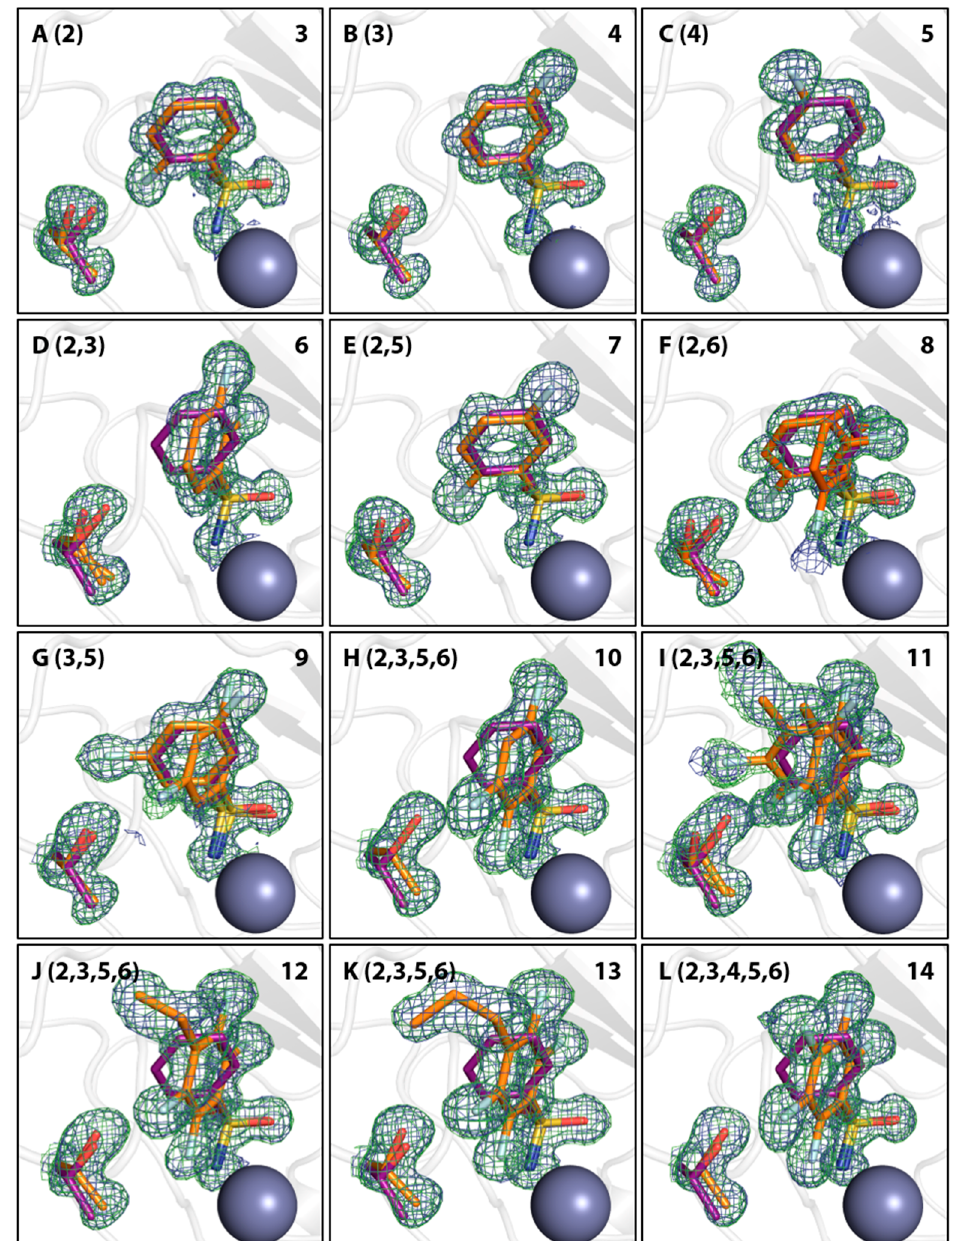
Figure 2. Binding modes of fluorinated compounds and side chains of the respective Thr200 residue in orange in images ( A – L ). Fluorinated positions at the phenyl ring relative to the sulfonamide bearing carbon atom (position 1) are given in parentheses. Compound numbers according to Table 1 are given in the upper right corner. Compound 1 is shown in all images for comparison in purple. Omit 2mFo-DFc density is shown in blue at 1 σ and omit mFo-DFc density in green at 3 σ . The Zn II cofactor is shown as gray sphere. Notably, fluorination patterns in compounds 8 , 9 , and 11 induce a second alternative binding pose.